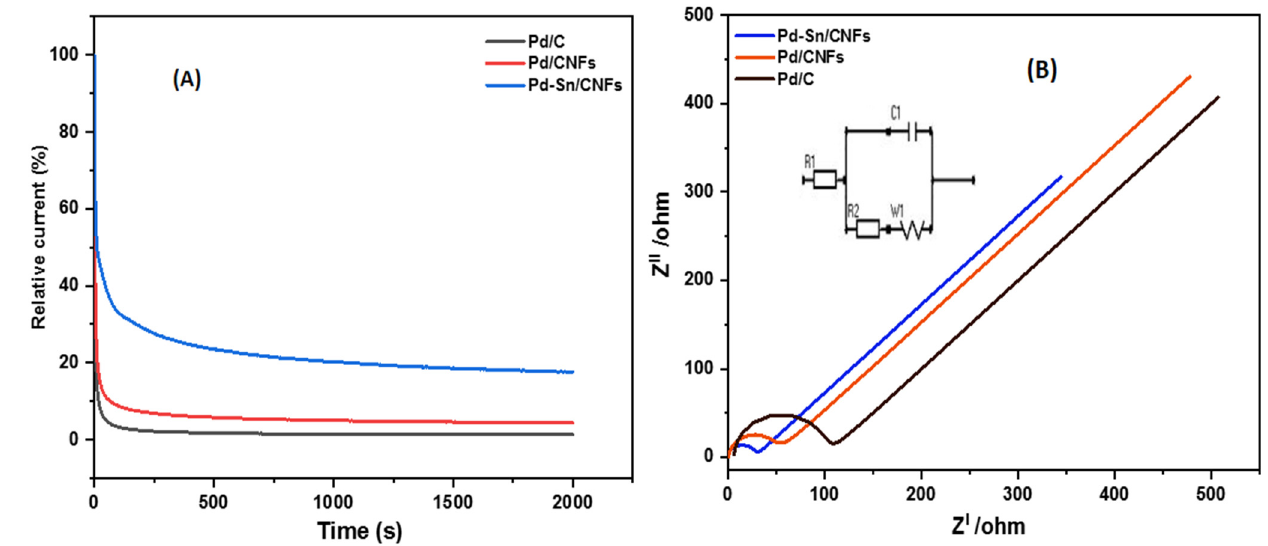
Figure 11. Chronoamperometric curves ( A ) and Nyquist plots of impedance spectra with corre- sponding equivalent circuit ( B ) of Pd/C, Pd/CNF and Pd-Sn/CNF electro-catalysts at 0.5 V in 1 M KOH + 1 M CH 3 CH 2 OH solution.